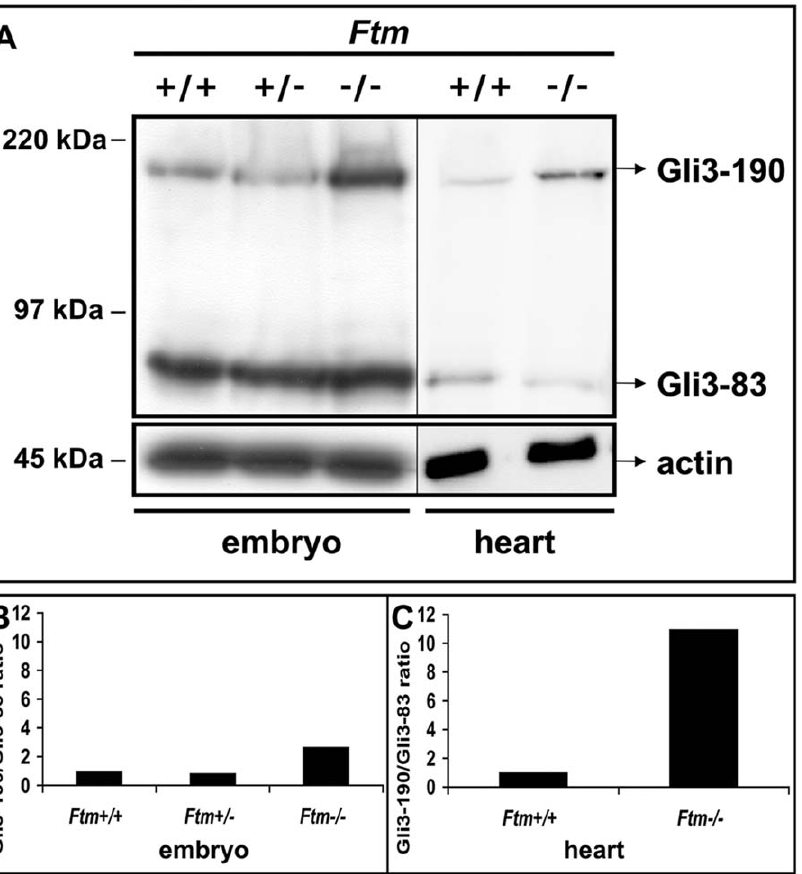
Figure 8. Ftm -negative hearts display a disturbance in Gli3 processing. (A) Western blot analysis of E11.5 embryo and heart protein lysates. Actin serves as loading control. In Ftm -negative embryos (n=3), there is more Gli3-190 protein than in wild-type littermates, but an equal amount of Gli3-83. The amount of Gli3-190 protein is higher in Ftm -deficient than in wild-type hearts (n=12, respectively), while conversely, there is less Gli3-83 in Ftm 2 / 2 hearts indicating a processing defect in Ftm -negative hearts. (B, C) Graphical evaluation of the Gli3-190/Gli3-83 ratio in wild-type and Ftm - deficient embryos and hearts, respectively. (B) The ratio of Gli3-190/Gli3-83 is 2.64 fold elevated in Ftm -homozygous mutant embryos. (C) Gli3-190/ Gli3-83 ratio is 10.94 fold increased in Ftm -negative